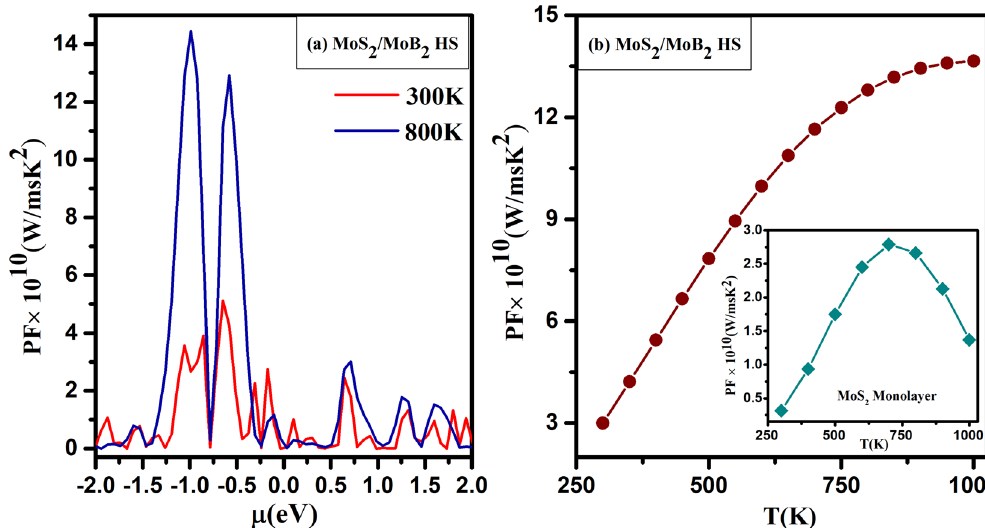
Figure 12. Power factor as a function of ( a ) chemical potential ( μ ( eV )) and ( b ) Temperature T(K) of MoS 2 / MoB 2 HS and inset of ( b ) Temperature T(K) of MoS 2